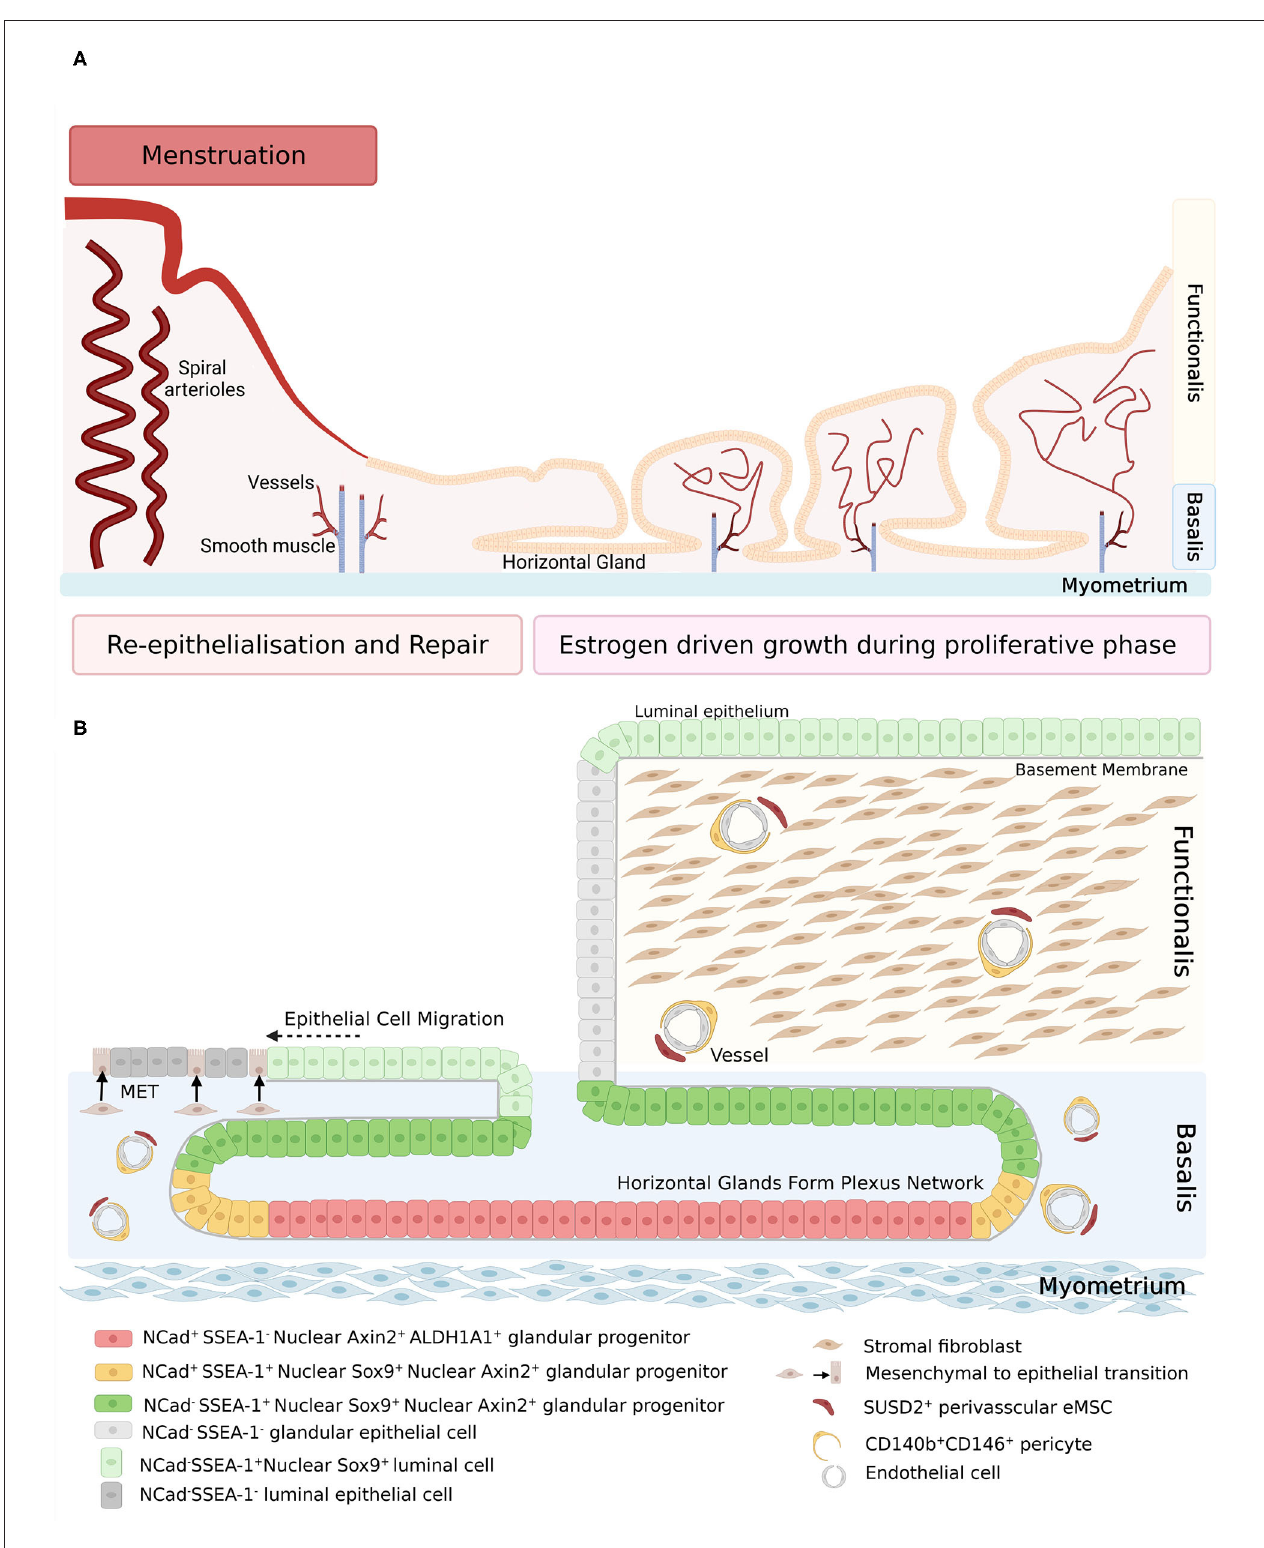
FIGURE 1 | (A) Schematic of human endometrium in menstrual and proliferative phases. (B) Schematic of human endometrial mesenchymal stem cell and epithelial stem/progenitor hierarchy in menstruating and proliferating endometrium. During re-epithelization, SSEA-1 + epithelial cells (light green) migrate from the stumps of residual glands across the denuded surface, with some evidence of mesenchymal to epithelial transition of stromal fibroblasts (brown). During the proliferative phase,